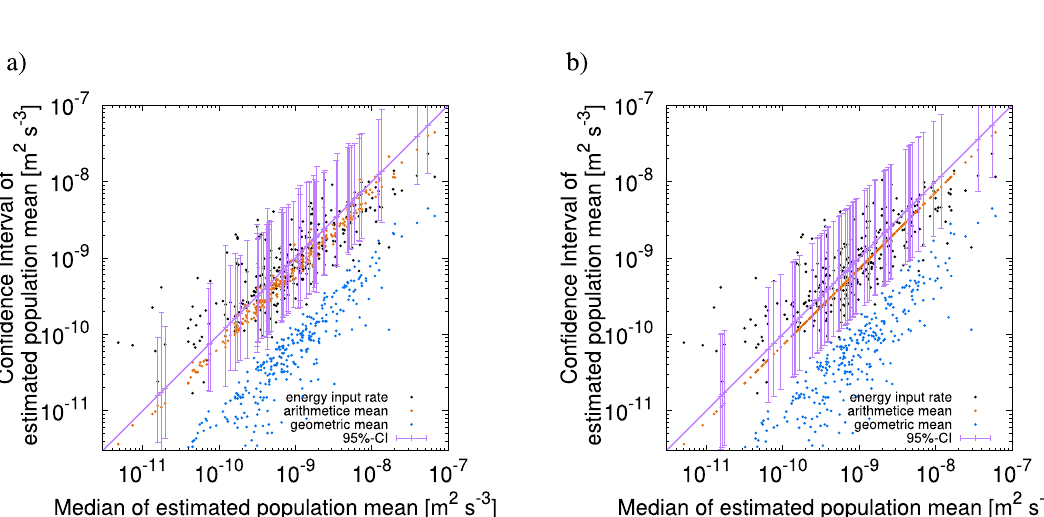
Figure 10. Result of identical twin experiments. Median (horizontal axis) versus confidence interval (vertical axis) of ǫ . ( a ) Result using probability density function q 3 ( ·| u , v ) . ( b ) Result using probability density function q 1 ( · ) . For given values of the median on the horizontal axis, the points on the vertical axis indicate the values of the confidence interval (purple segment), arithmetic mean (orange), geometric mean (blue), and energy input rate (black). For readability, 300 points and 60 intervals are drawn out of 30,000